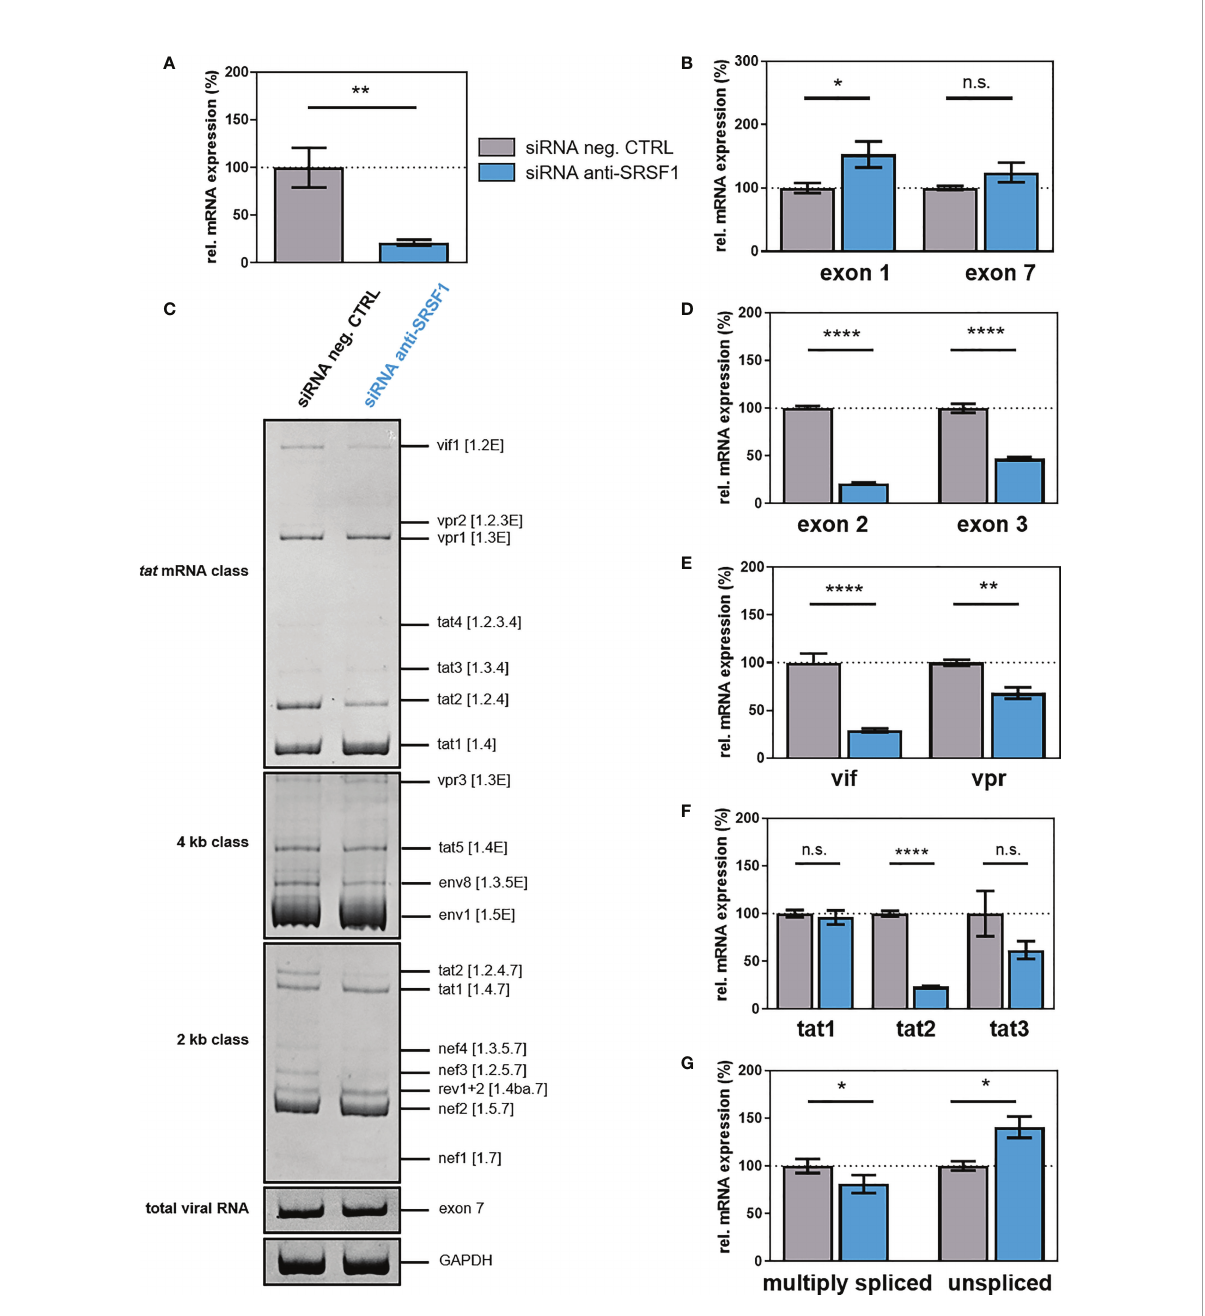
FIGURE 7 siRNA-mediated knockdown of SRSF1 affects HIV-1 LTR transcription and splice site usage. HEK293T cells were transfected with the proviral clone pNL4-3 PI952 and anti-SRSF1 siRNA or an siRNA negative control. Seventy-two hours post-transfection, cells were harvested and RNA and viral supernatant was isolated. Isolated RNA was subjected to RT-qPCR. (A, B) Relative mRNA expression levels of (A) SRSF1 and (B) exon 1- and exon 7- containing mRNAs (total viral mRNA) normalized to GAPDH expression. (C) Analysis of viral splicing pattern upon SRSF1 knockdown. Isolated RNA was subjected to RT-PCR analysis using the indicated primer pairs for the 2-kb, 4-kb, and tat mRNA class (Supplementary Table 1, Supplementary Table 2, and Supplementary Figure 4). HIV-1 transcript isoforms are depicted on the right according to Purcell and Martin (36). To compare total RNA amounts, separate RT-PCRs amplifying HIV-1 exon 7-containing transcripts as well as cellular GAPDH were performed. PCR amplicons were separated on a 12% non-denaturing polyacrylamide gel. (D – G) Relative expression levels of (D) exon 2- and exon 3-containing, (E) vif and vpr , (F) tat1 , tat2 , and tat3 , and (G) multiply spliced and unspliced mRNAs. HIV-1 mRNAs were analyzed using the indicated primers (Supplementary Table 1, Supplementary Table 2, and Supplementary Figure 4). The mRNA expression of NL4-3 PI952 was set to 100%, and the relative splice site usage was normalized to total viral mRNA levels (exon 7-containing mRNAs). Unpaired two-tailed t -tests were calculated to determine whether the difference between the group of samples reached the level of statistical signi fi cance (* p < 0.05, ** p < 0.01, **** p < 0.0001 and ns, not signi fi cant). Mean ( ± SEM) of n = 4 biological replicates is depicted for (A) , (B) , and (D – G) . For (C) , a representative gel is